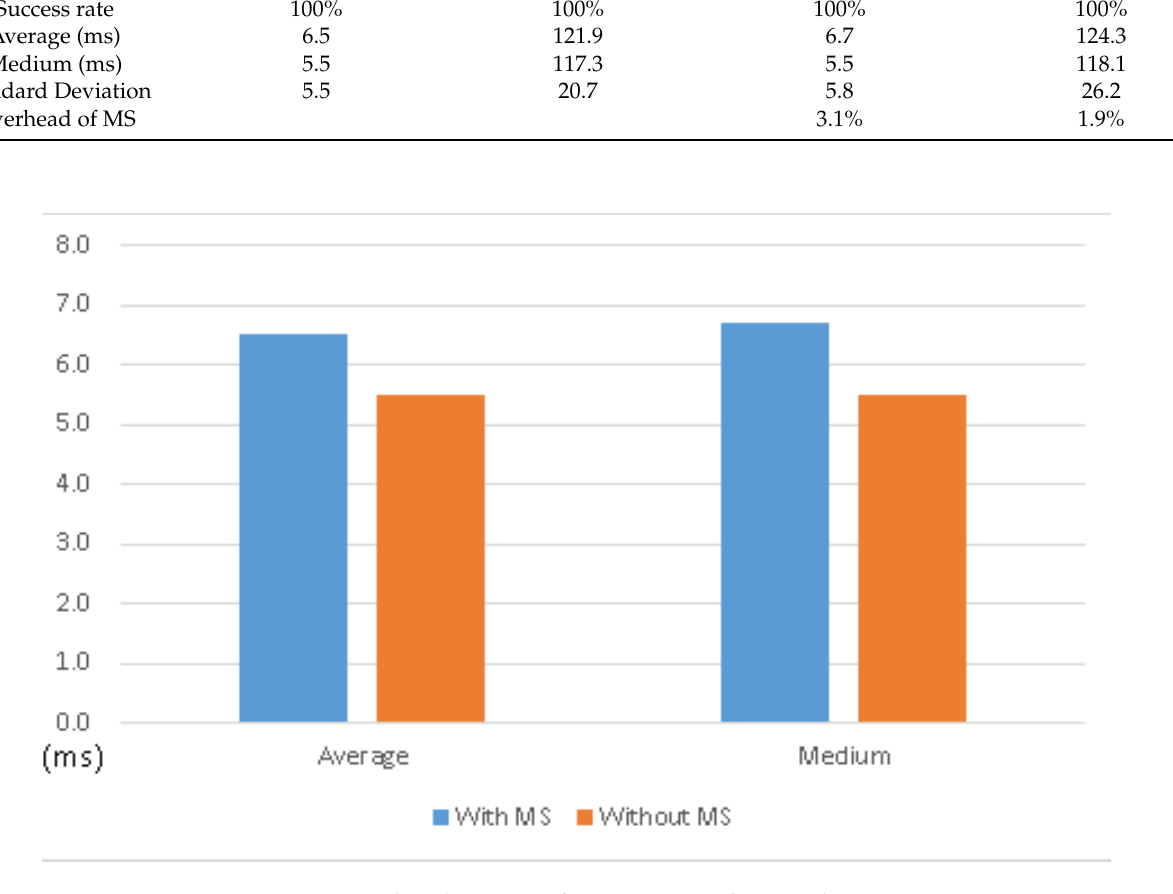
Figure 10. Average time and medium time of testing existing functionality — new connection.